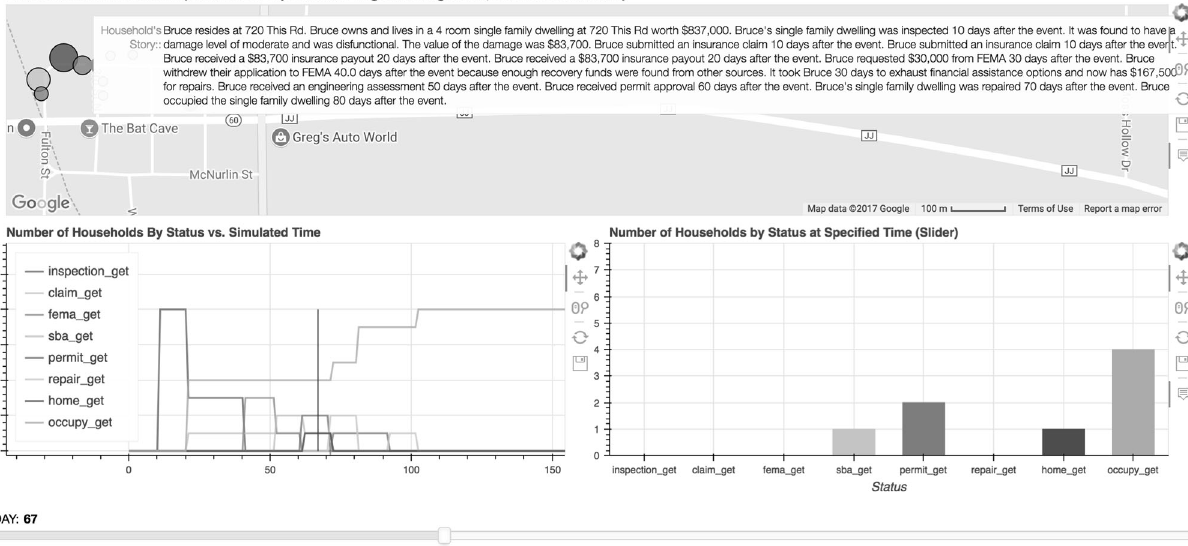
Fig. 3 Alpha prototype of a component of a browser-based visual analytics dashboard for DESaster as part of a participatory modeling